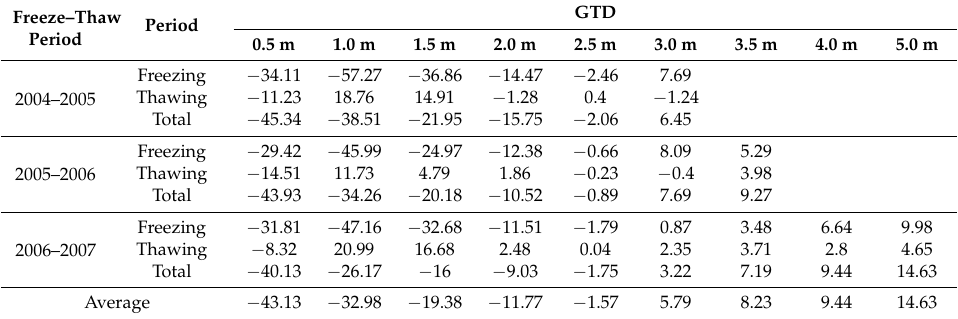
Table 10. Results of the difference between phreatic evaporation and recharge to groundwater with sandy loam during freeze–thaw periods. Unit: